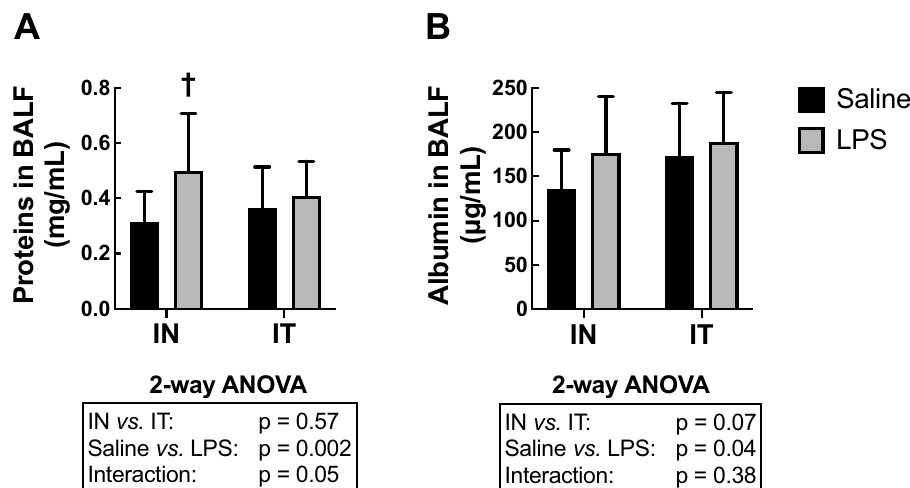
Figure 5. Protein extravasation into the alveoli. The concentration of ( A ) total proteins and ( B ) albumin in bronchoalveolar lavage fluid (BALF) are depicted for mice treated with either saline (black) or LPS (grey) through either the intranasal (IN) or the intratracheal (IT) route. The results of the two-way ANOVA are shown at the bottom of each graph. †Indicates statistically significant from the group treated with saline exposed through the same route. n = 18 per group and the data shown are means ± SD.